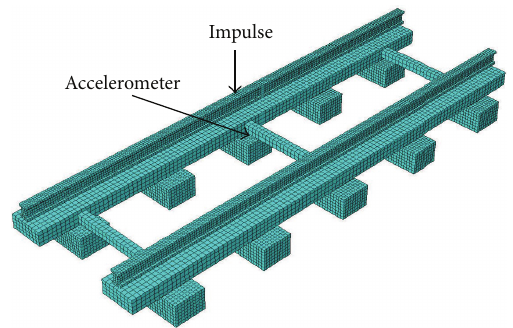
Figure 8: FEM model established by LS-DYNA.